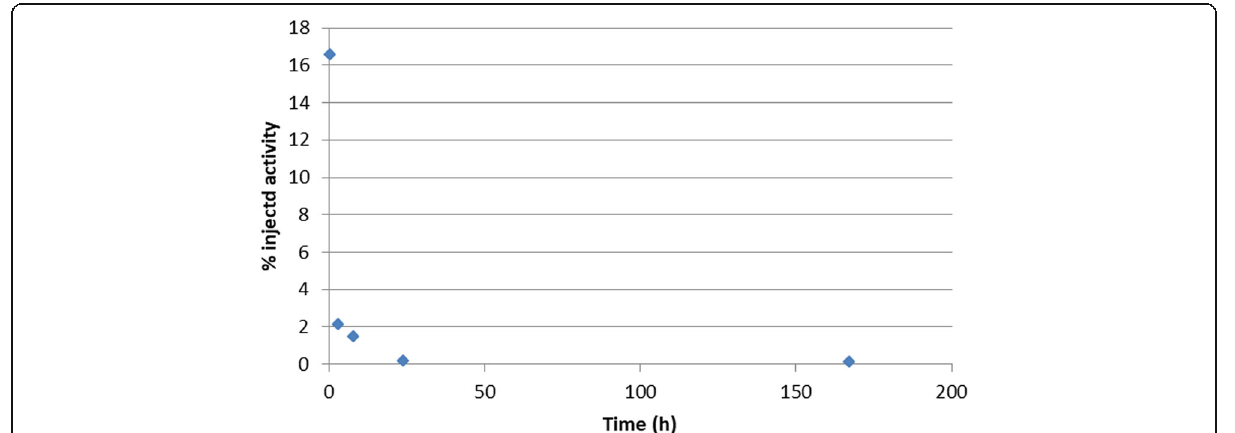
Fig. 4 Blood clearance curve in patient no. 4 with bronchial carcinoma